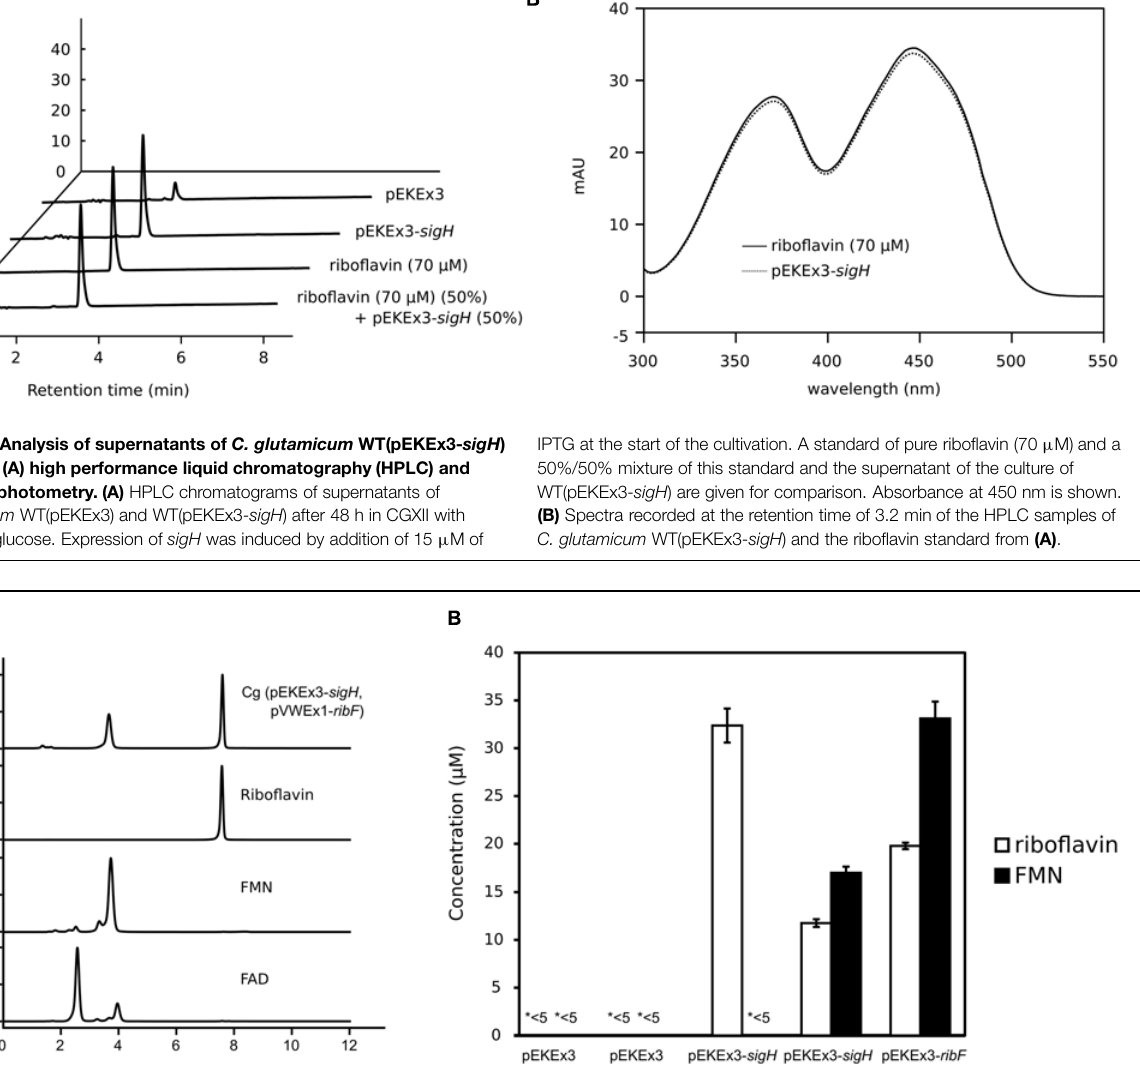
FIGURE 4 | Analysis of supernatants of C. glutamicum WT(pEKEx3- sigH , pVWEx1- ribF ) cultures by HPLC (A) and riboflavin and FMN concentrations in supernatants of various strains (B). (A) HPLC chromatograms of supernatants of C. glutamicum WT(pEKEx3- sigH , pVWEx1- ribF ) after 48 h in CGXII with 222 mM of glucose. Expression of sigH was induced by addition of 100 μ M of IPTG in the middle of the exponential